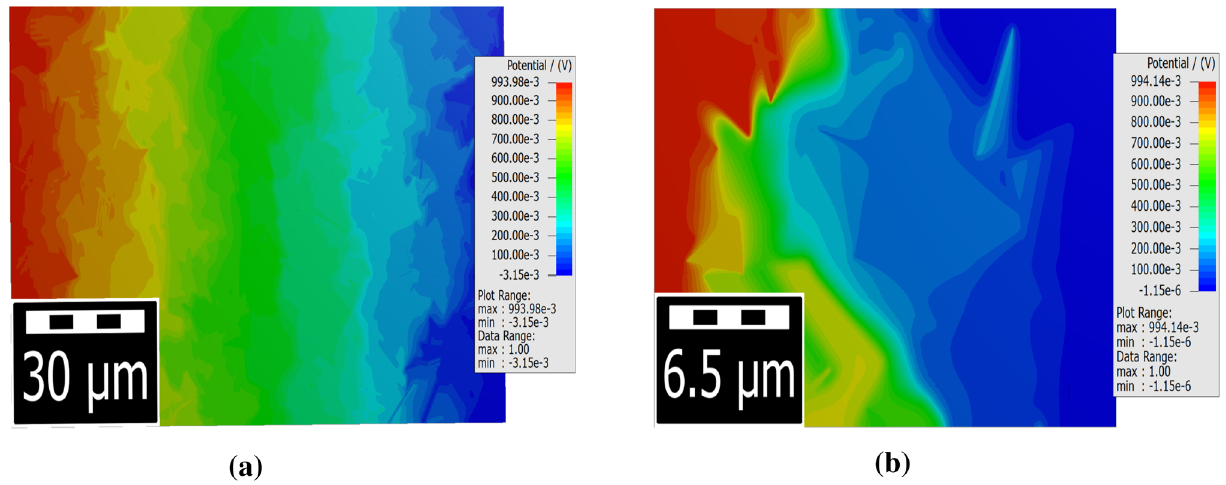
Fig. 4 Visualisation of the potential distribution for a full-scale a and a small detail b of a graphene ink layer